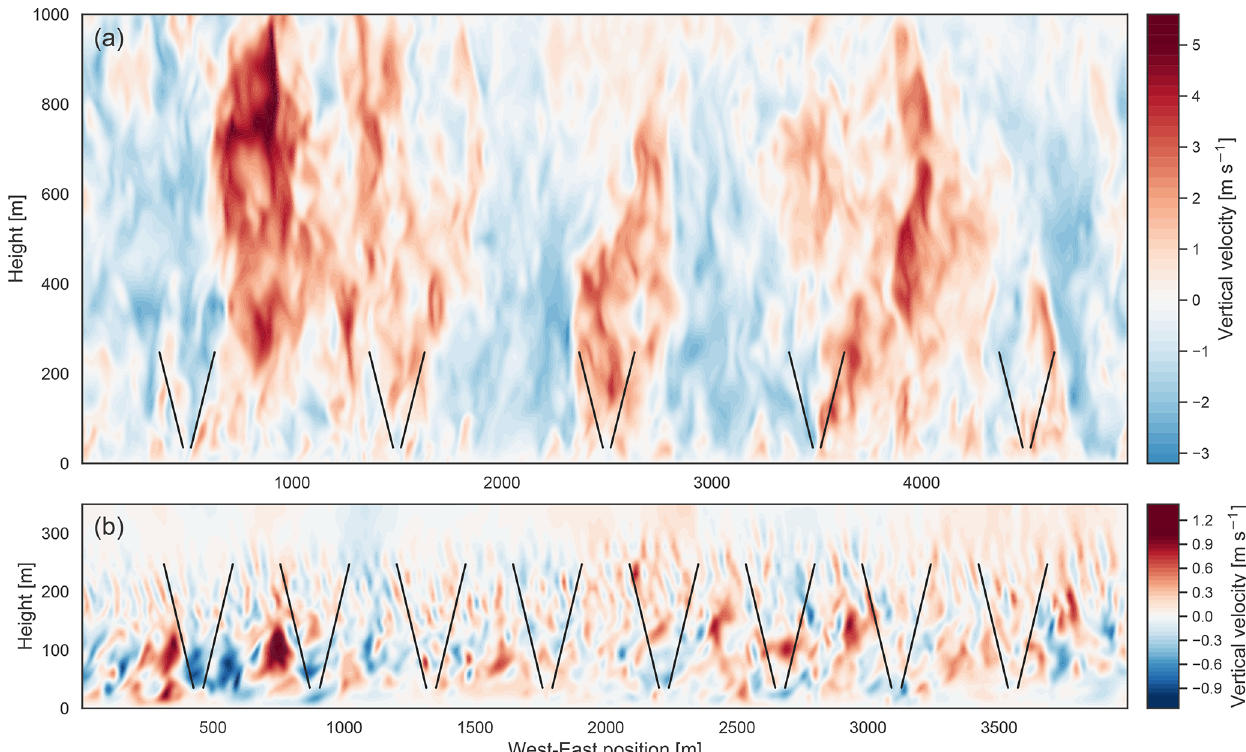
Figure 4. Instantaneous slice of vertical velocity across the west–east plane in (a) the strong CBL and (b) the stable BL. The WindCube V2 scan geometry is shown for reference by the beams in